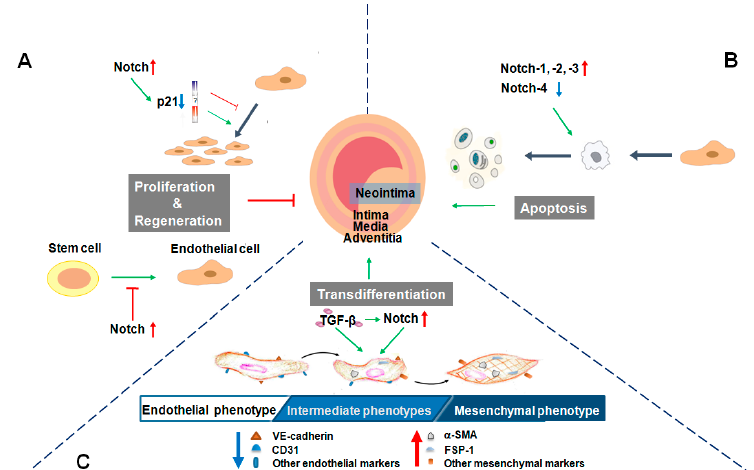
Figure 2. Notch signaling modulates endothelial cells’ (EC) fate associated with neointimal hyperplasia. ( A ) EC proliferation reduces neointimal hyperplasia. Notch signaling may have dual function in EC proliferation, which is dependent on the relative level of p21 expression. If the expression of p21 is above the level, Notch activation inhibits EC proliferation, however, ECs grow and proliferate when the expression of p21 is below the level. In addition, activation of Notch blocks EC regeneration and induces neointimal hyperplasia; ( B ) EC apoptosis contributes to neointimal hyperplasia. Upregulation of Notch-1, Notch-2, Notch-3 and downregulation of Notch-4, promote EC apoptosis, which further promotes neointimal hyperplasia; ( C ) Endothelial-mesenchymal transition (EndMT) contributes to neointimal hyperplasia. Notch activation can trigger EndMT and promote neointimal hyperplasia. The canonical EndMT inducer TGF- β (transforming growth factor- β ) also can activate the Notch signaling pathway. FSP-1, fibroblast-specific protein 1; CD31, also known as platelet endothelial cell adhesion molecule-1 (PECAM-1).